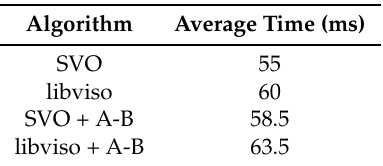
Table 8. Experiment 3: Average Computation